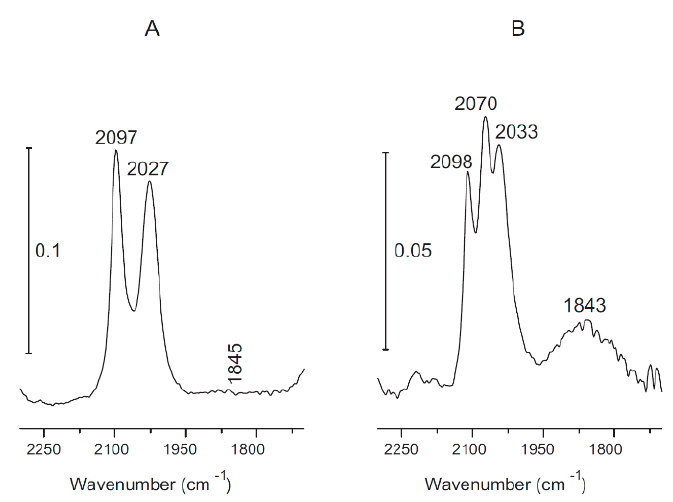
Figure 8. FTIR spectra of adsorbed CO at 300 K: ( A ) 1% Rh/TiONW and ( B ) 0.5% Au + 0.5% Rh/TiONW. Reproduced from